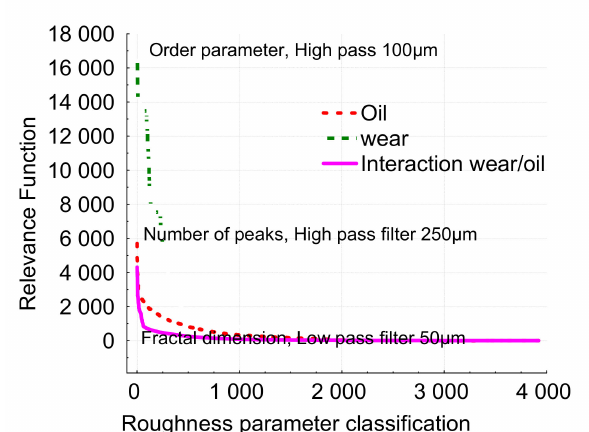
(cid:16) (cid:17) S k , ε , λ , p i corresponding to oil e ff ect, friction time e ff ect